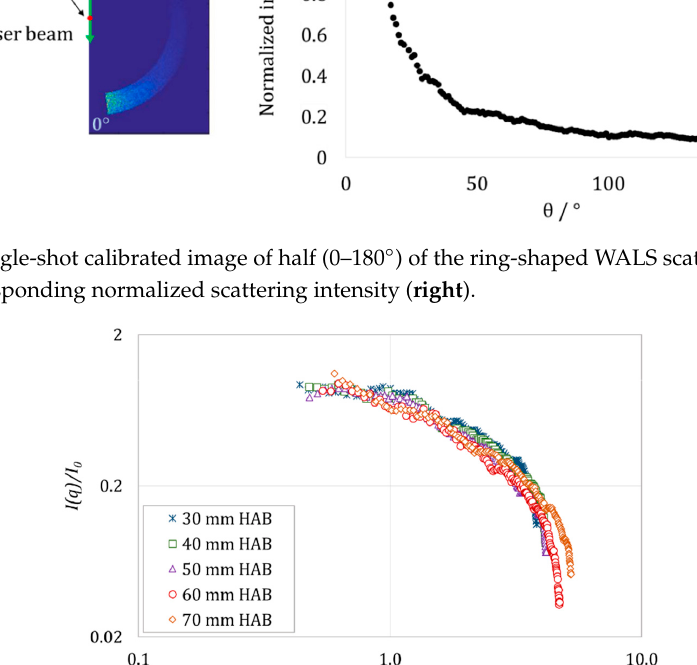
Figure 14. Distribution of the effective R g,eff at 30, 40, 50, 60, and 70 mm HAB for the baseline diesel CEC RF-79-07. In Figure 15 the comparison of the median values µ g,eff obtained at various HAB for the two fuels under study is reported. To further compare the results, arbitrary subsamples of about 200 are drawn from the full sample at each HAB, yielding a standard deviation of the µ g,eff , which on average is 7 nm. Although µ g seems to be slightly higher for the baseline diesel between 40 and 60 mm above the burner, within the statistical uncertainty of the results a difference in aggregate size between the two fuels cannot be stated clearly, the aggregation process itself does not seem to alter for the different fuels.